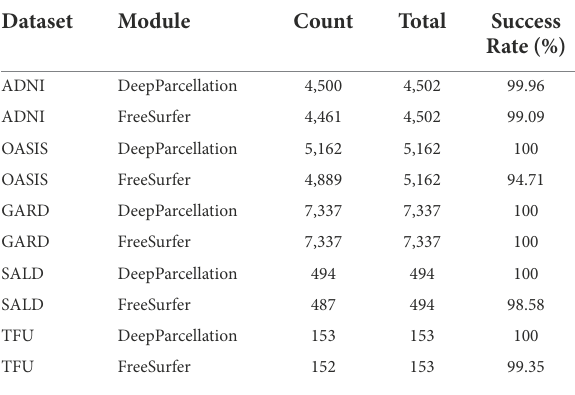
TABLE 2 Processing success rate of DeepParcellation and Freesurfer showing absolute numbers and